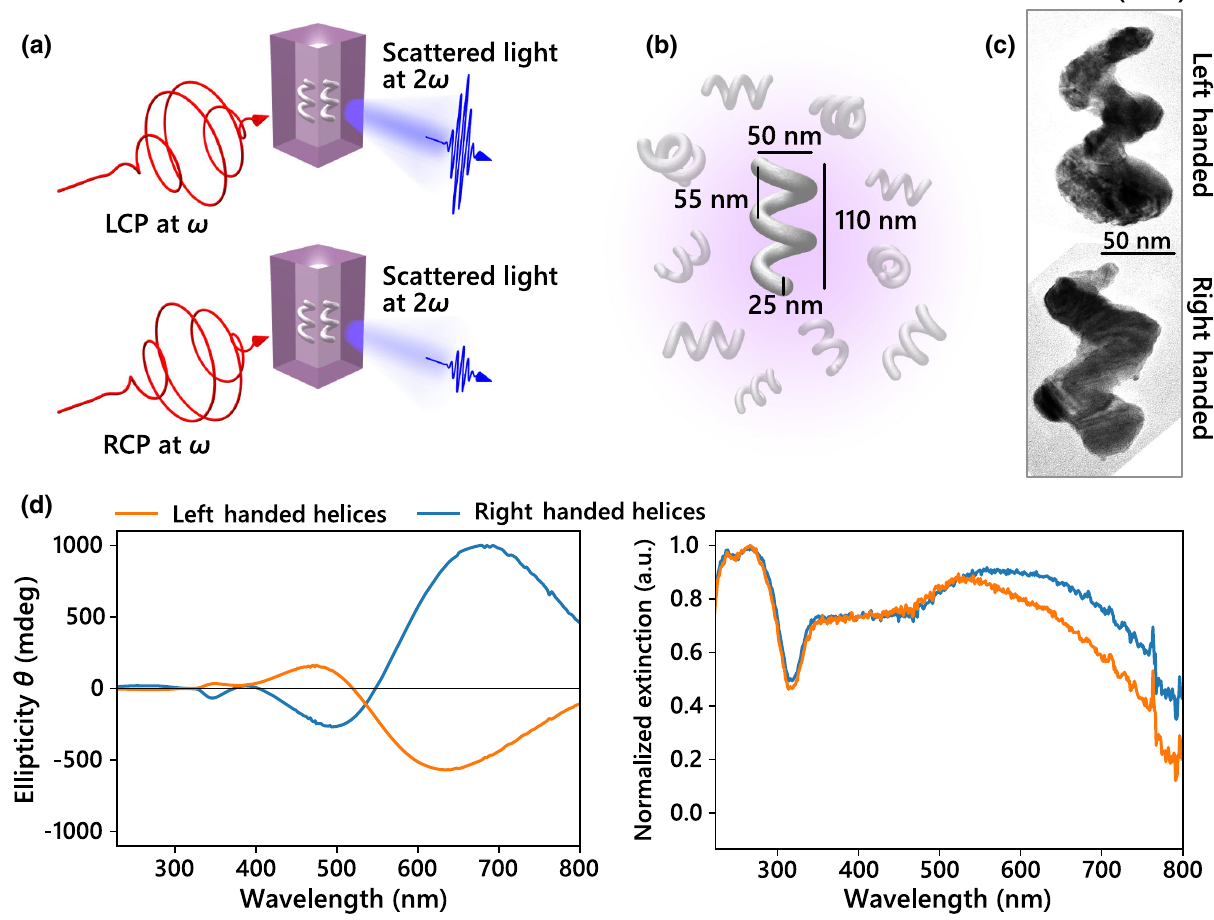
FIG. 1. Hyper-Rayleigh scattering circular dichroism produced by plasmonic nanohelices. (a) Schematic of the HRS CD effect. (b) Dimensions (center to center) of the nanohelices isotropically dispersed in water. Helix height is 110 nm, loop diameter is 50 nm, loop pitch is 55 nm, and wire diameter is 25 nm. (c) TEM images of left- and right-handed helices. (d) Linear characterization of the nanohelix solutions. Left: Ellipticity spectra as measured with a CD spectrometer through a 1-cm path length filled with left- and right- handed nanohelix suspensions. Right: Corresponding normalized extinction spectra from the left- and right-handed nanohelix suspensions. Extinction is obtained from the transmission spectrum and describes both absorption and scattering